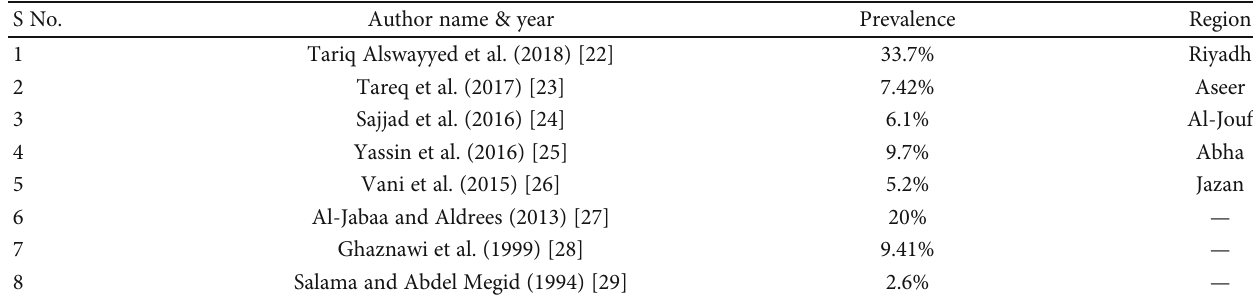
Table 1: The prevalence of congenitally missing teeth in the di ff erent regions of Saudi Arabia. S No.